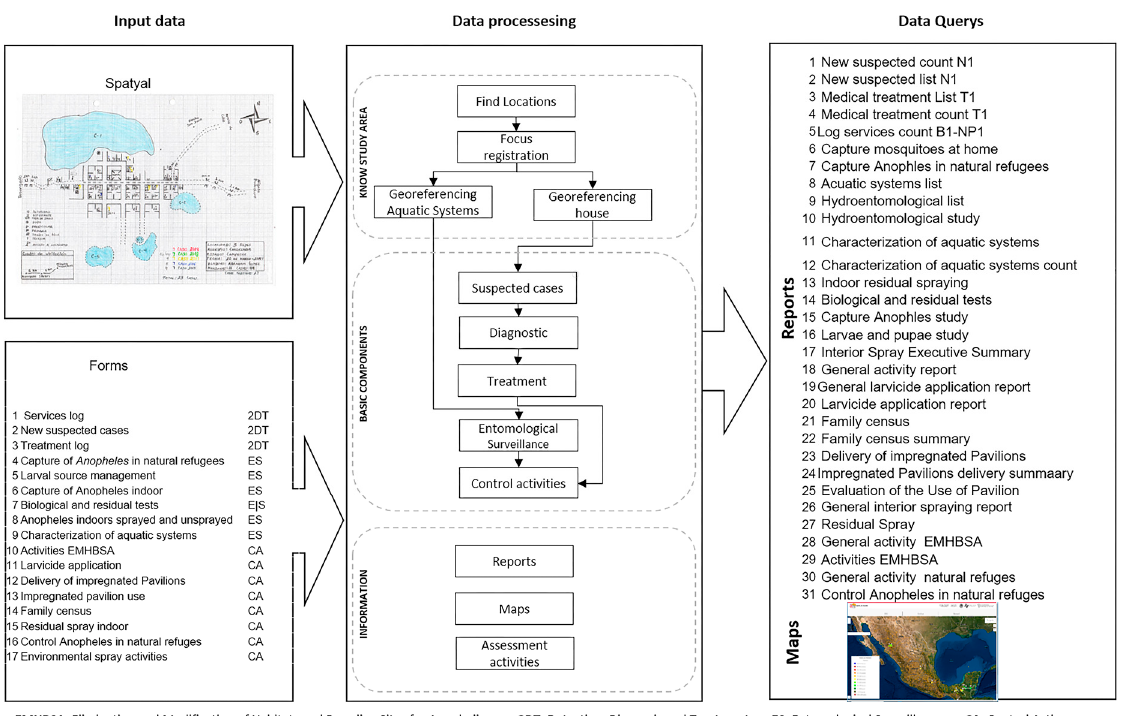
Figure 5. Data input, process, and output scheme. The input data contains 17 forms. The data output is performed through 32 reports, maps, and a dashboard. Data is stored and processed in a geoda- tabase using Microsoft SQL